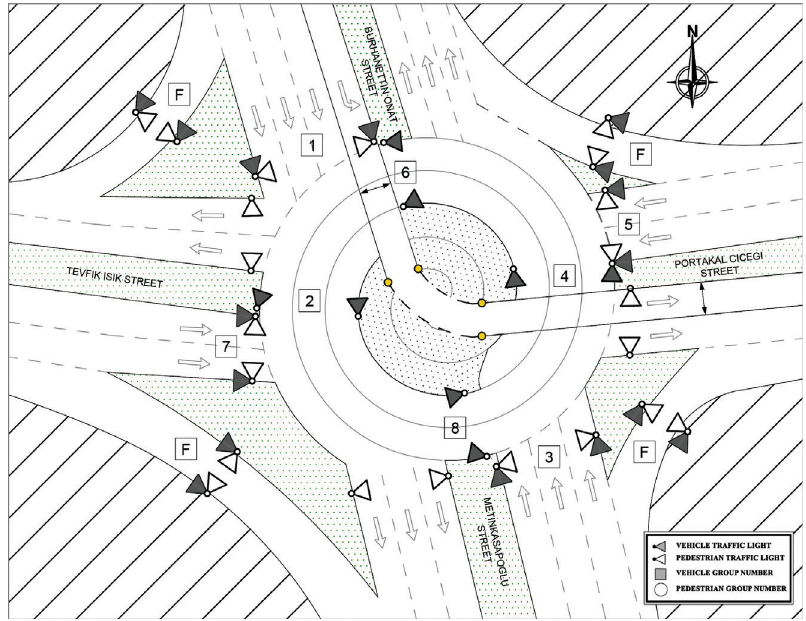
Figure 3. The plan view of Burhanettin Onat Street – Metin Kasapoglu Street roundabout for the proposed design (by Y. User & S.